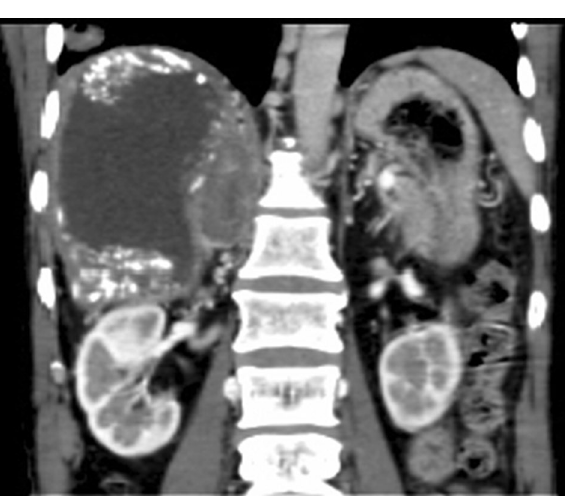
Figure 1. Multiple irregular nodules with different morphology in MSCT lung setting image ( a ) and mediastinum setting image ( b ).